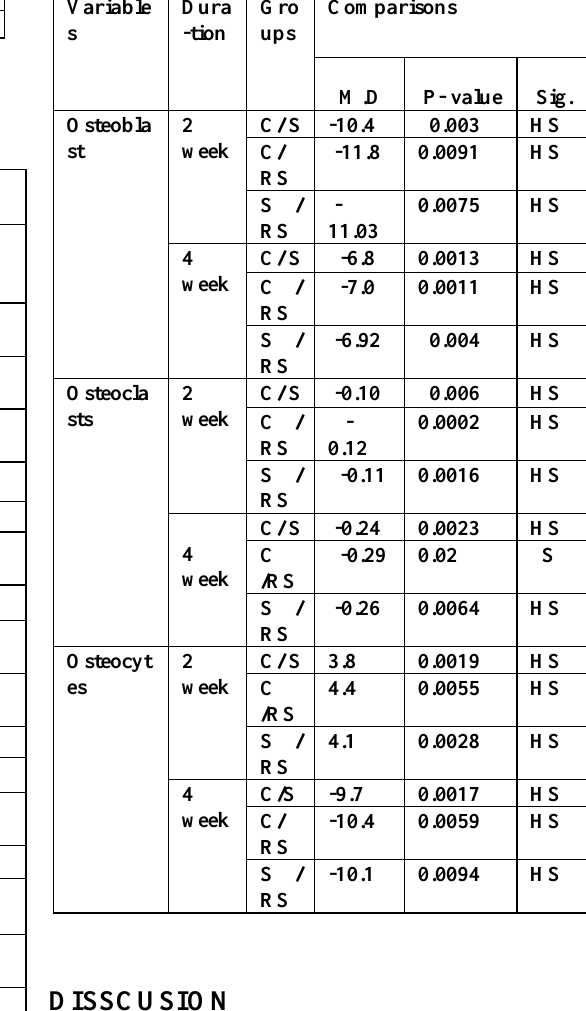
Table 3: LSD group differences in bone cells.